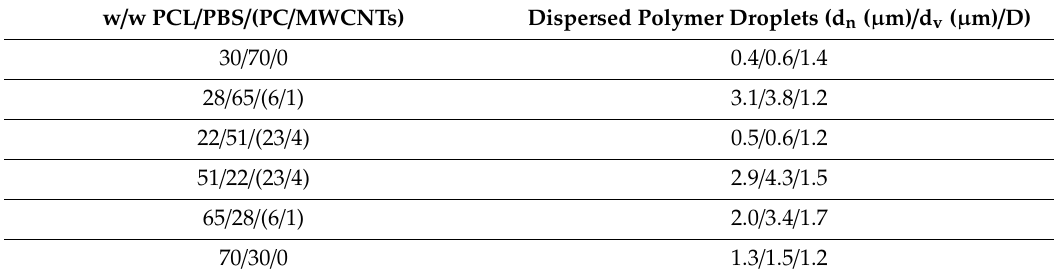
Table 2. Particle sizes of the dispersed polymer phases in the PCL / PBS